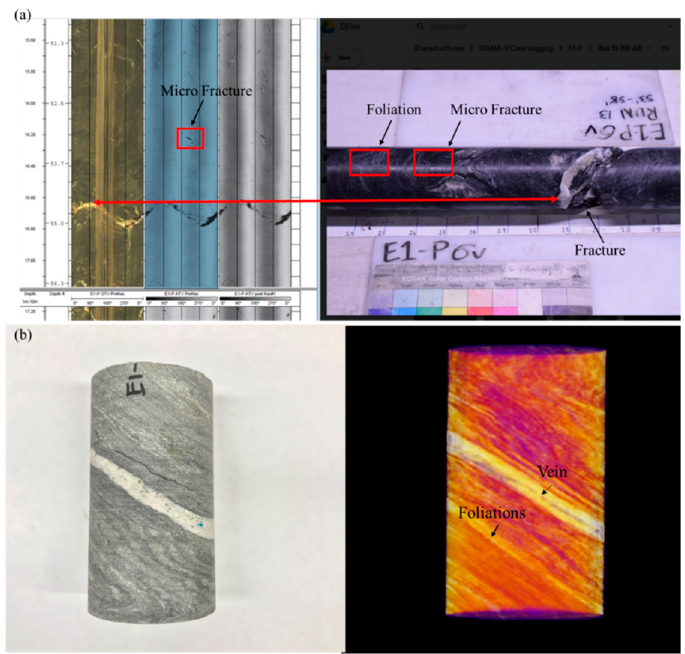
Figure 2. ( a ) Acoustic televiewer log showing the fracture orientation, foliation and micro fracture in borehole E1-P from Collab EGS. ( b ) Poorman Schist sample from E1-PDT 99.3 ~ 100.25 ft and (Computed Tomography) CT-scan image of the sample (the sample was CT scanned at Berkeley Lab). The rock sample is from Collab EGS and diameter is 61 mm and length is 110 mm. The details of reservoir rock can be found in [3].